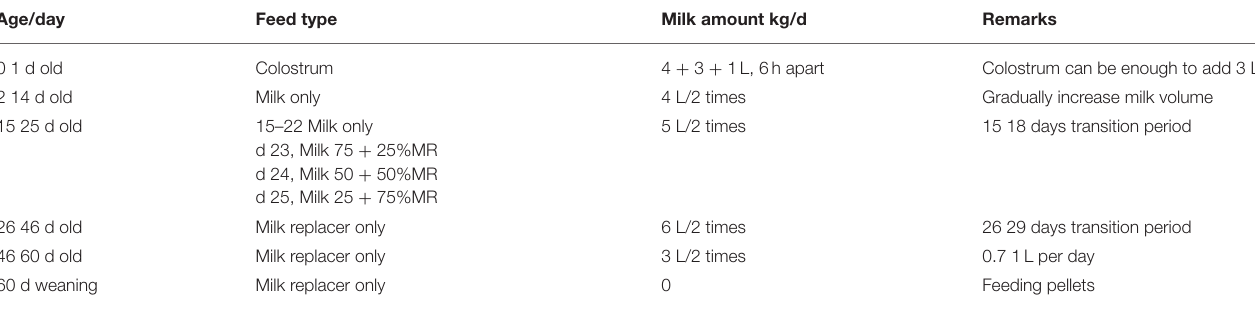
TABLE 2 | The daily amount of milk and milk replacer (MR) fed to Holstein heifer calves during the sucking period from birth to 60 days after calving. Age/day